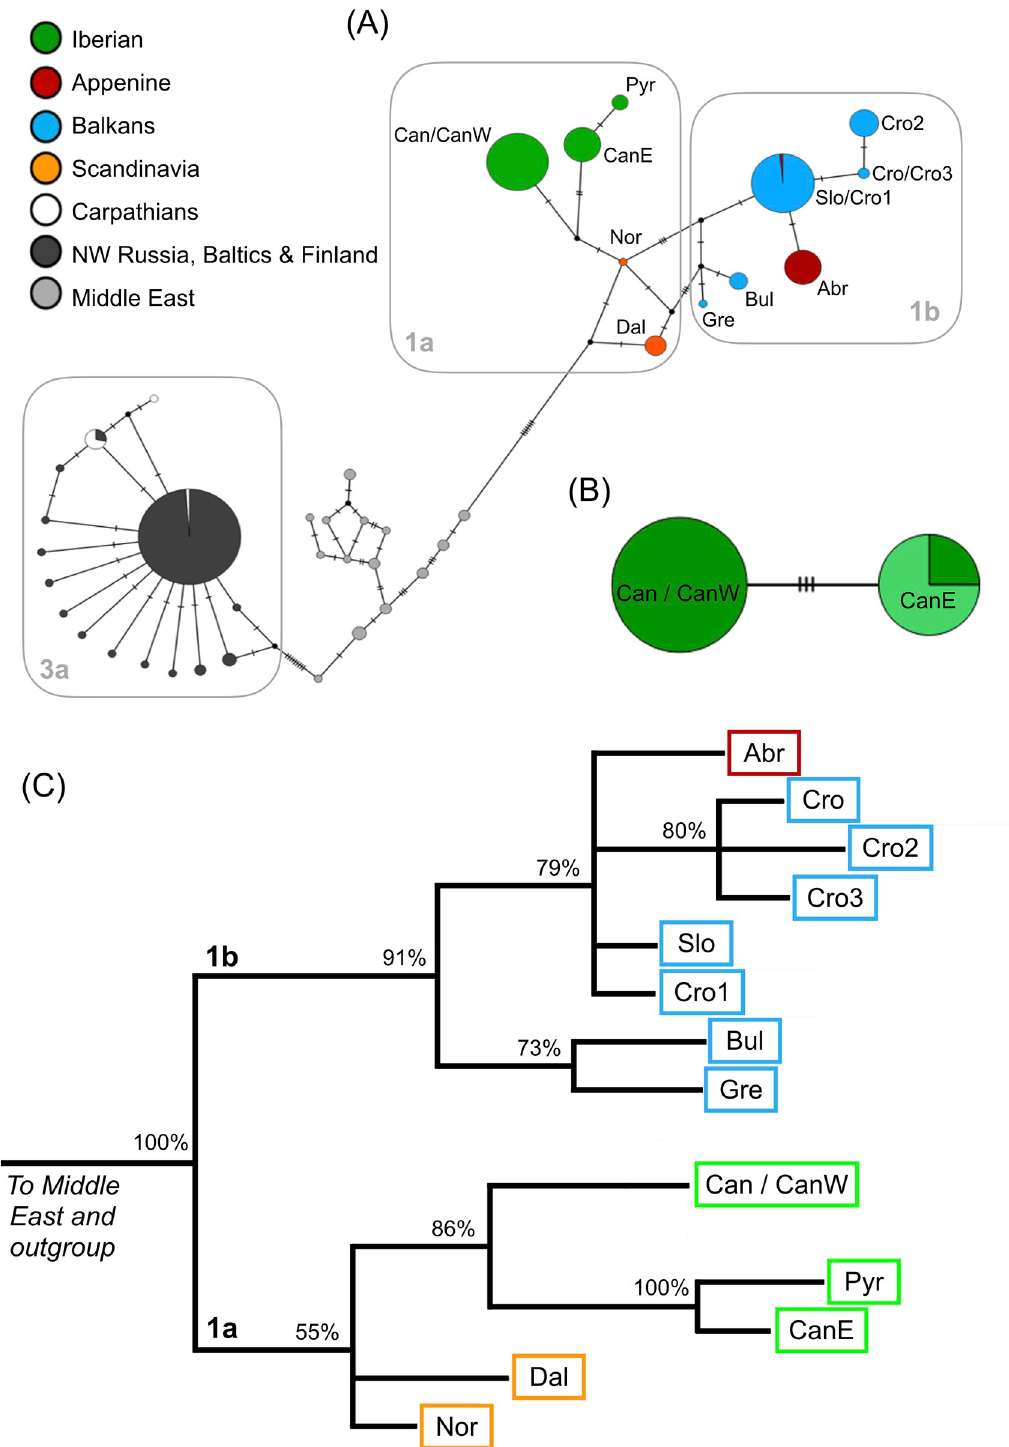
Fig 2. Phylogenetic and phylogeographic affinities of the Cantabrian brown bear with other European brown bear populations. (a) Median-joining network of 83 brown bear mtDNA haplotypes from across Europe and the Middle East. Haplotypes are colour-coded according to geographic origin, in agreement with the nomenclature given by Taberlet and Bouvet [14]. Iberian haplotypes have been named “CanW” and “CanE” according to their respective regions of origin in Cantabria. Mutational steps between haplotypes are represented by dashes. (b) Median-joining network of the two mtDNA